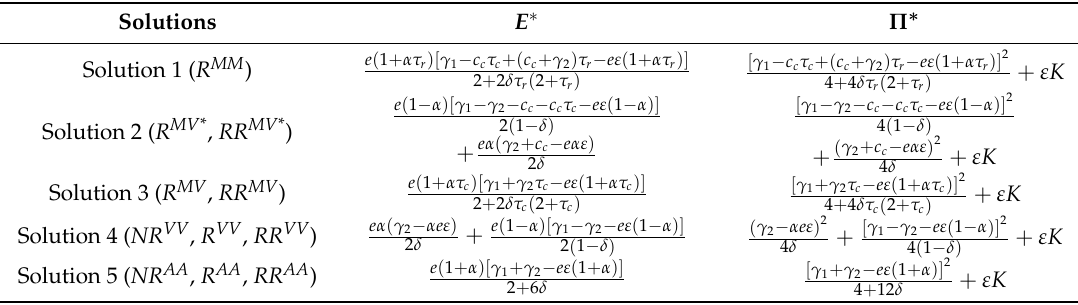
Table 7. Optimal profits and carbon emissions considering carbon cap-and-trade regulation.